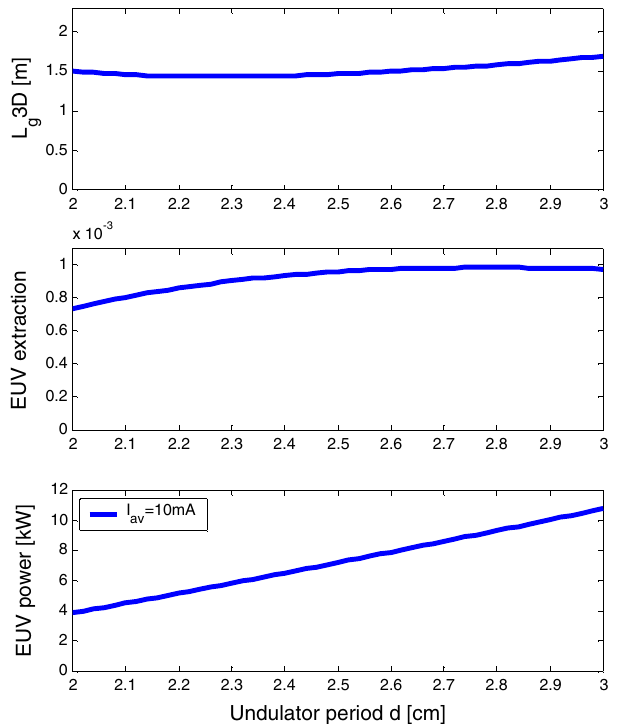
FIG. 5. Actual gain length L (3D), EUVextraction efficiency, g and extracted EUV power at 10 mA average current as functions of the undulator period d . Calculated according to parametric ¼ 150 A , normalized formula of Xie [18]. Bunch current I b